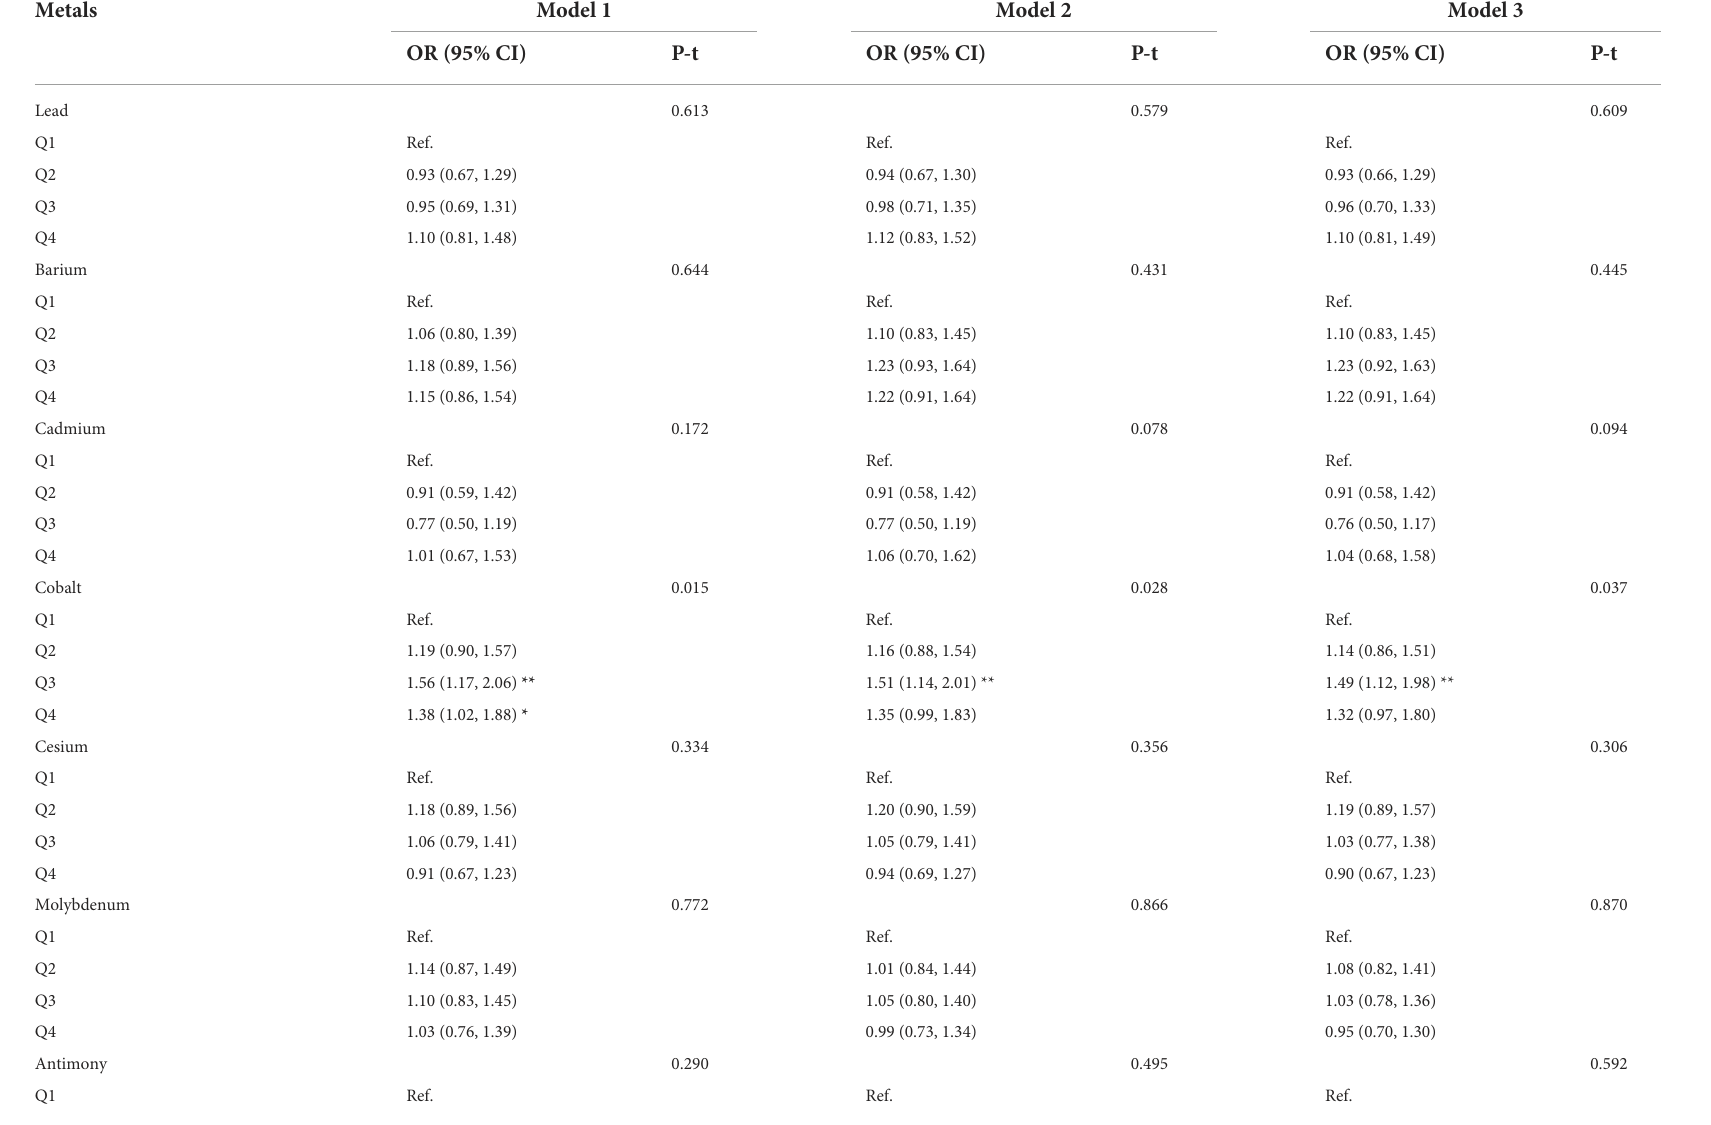
TABLE 2 Odds ratio for the association between urine trace metals and hearing